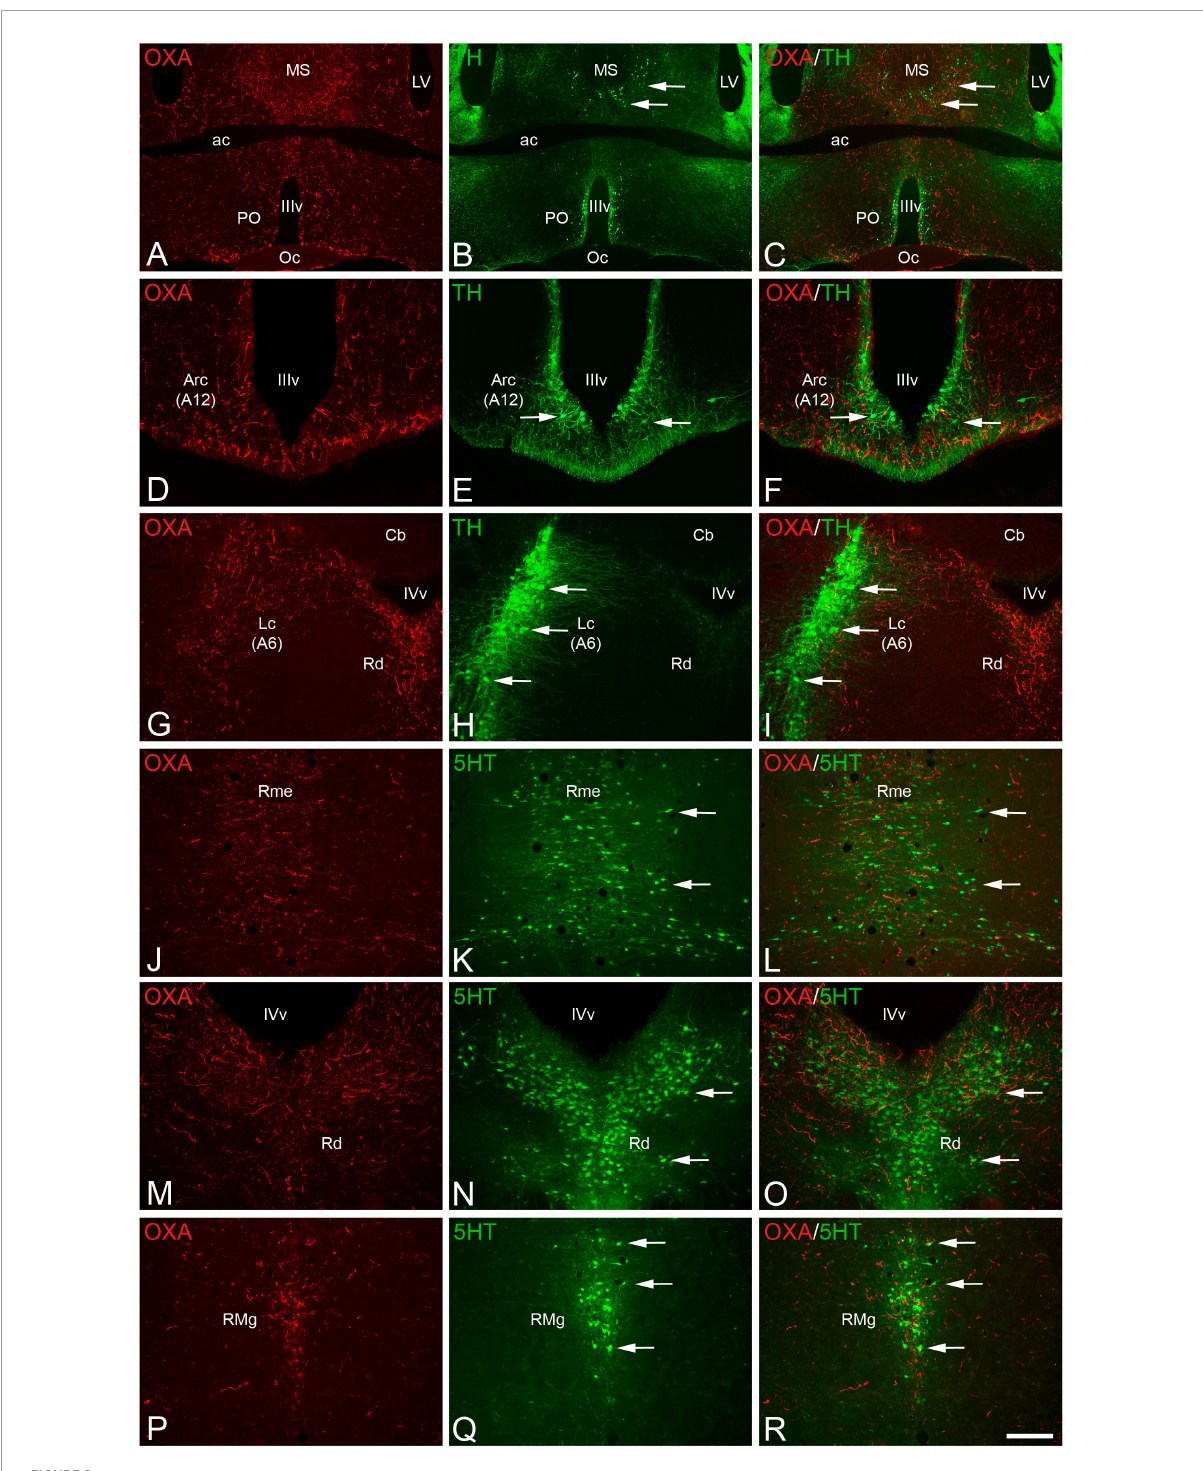
FIGURE2 (A,B,D,E,G,H,J,K,M,N,P,Q) Pair of fluorescence photomicrographs from OXA/TH (A–I) or OXA/5HT (J–R) double-immunostained sections through different antero-posterior levels of the brain of Mesocricetus auratus showing the overlapping of orexinergic fibers (red fluorescence) and catecholaminergic (A–I) or serotonergic (J–R) neurons (arrows). (C,F,I,L,O,R) Merged images. Scale bar, shown in panel (R) , indicates 1,225 µ m in panels (A–C) and 385 in panels (D–R) . ac, anterior commissure; Arc, arcuate nucleus; A6, noradrenergic cell group of locus coeruleus; A12, dopaminergic cell group of arcuate nucleus; Cb, cerebellum; Lc, locus coeruleus; LV, lateral ventricle; MS, medial septum; Oc, optic chiasm; PO, preoptic area; Rme, median raphe nucleus; Rd, dorsal raphe nucleus; RMg, magnus raphe nucleus; IIIv, third ventricle; IVv, fourth